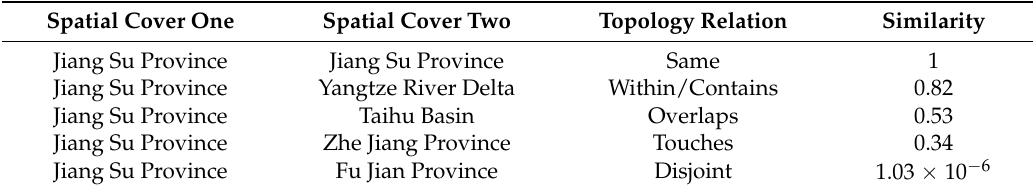
Table 12. Spatial coverage pairs with different topology relations and similarities. Spatial Cover One Spatial Cover Two Topology Relation